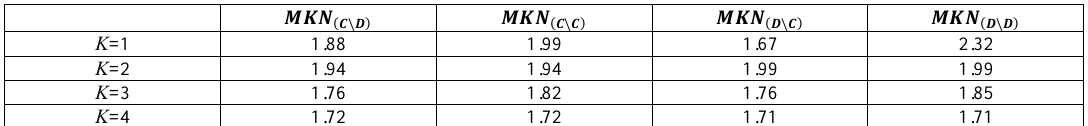
Table 3. MKN indices for time series C & D